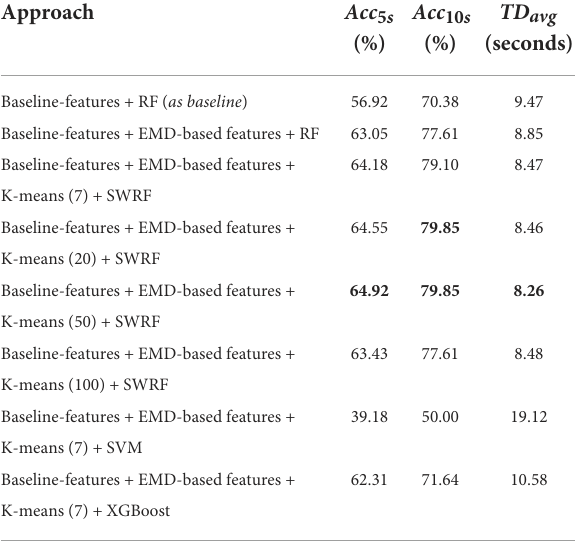
TABLE 2 The evaluation results of PGES detection with different